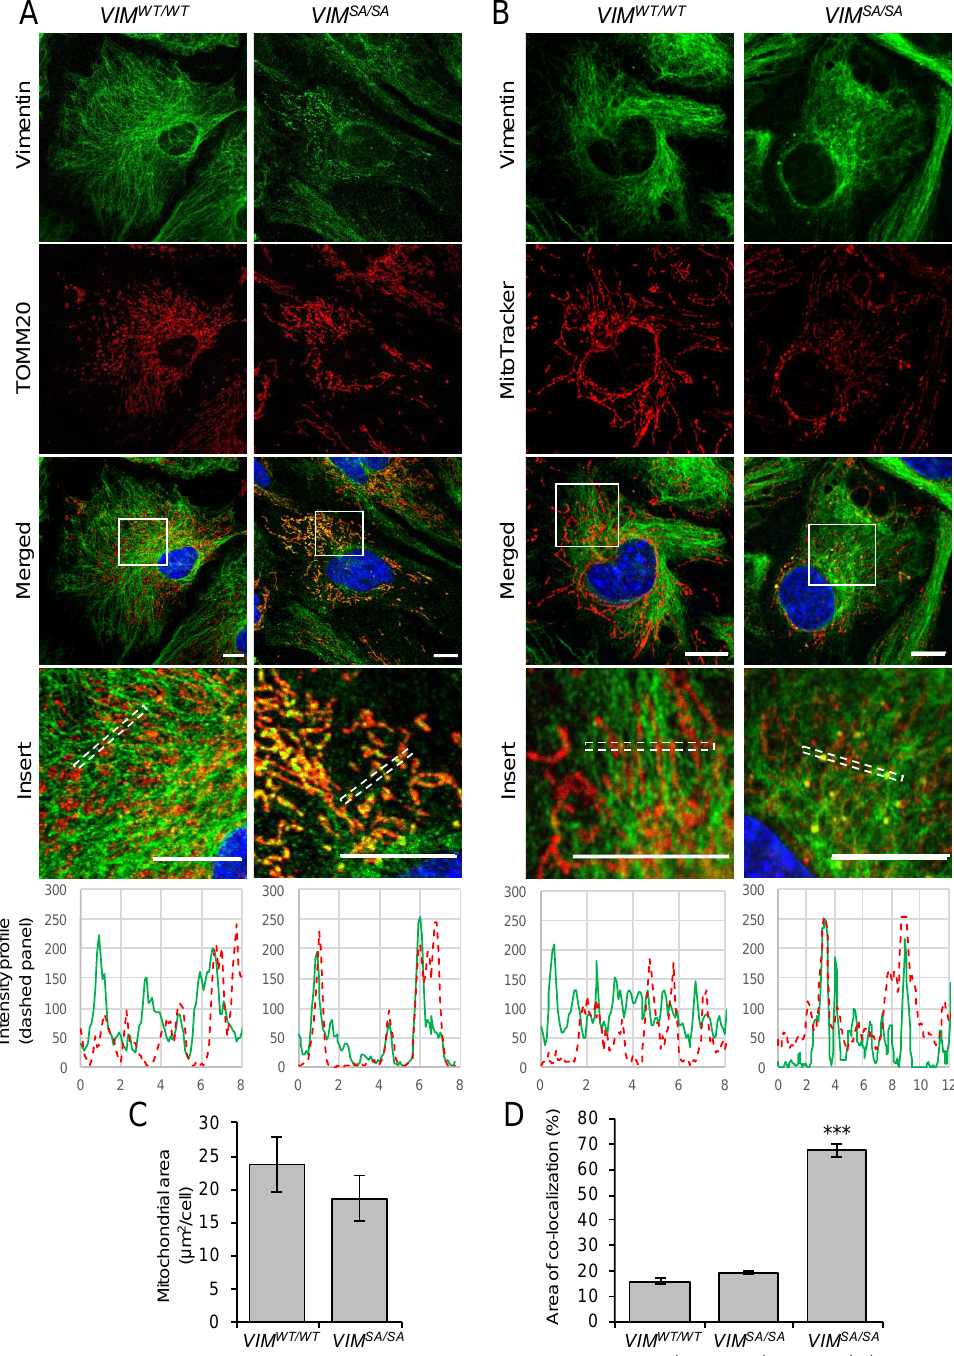
Figure 2. Vimentin accumulations co-localize with mitochondria. Immature VIM SA / SA astrocytes were labeled with polyclonal antibodies against vimentin (green) and the mitochondrial protein TOMM20 (red, A ) or the fluorescent mitochondrial probe MitoTracker (red, B ). Nuclei were visualized with DAPI (blue). ( C ). Mitochondrial area was measured from MitoTracker images. ( D ) The area of vimentin co-localization with MitoTracker was measured for total vimentin immunofluorescence and vimentin accumulations. N = 11 and 12 per genotype. Scale bar 10 µm. *** p < 0.001